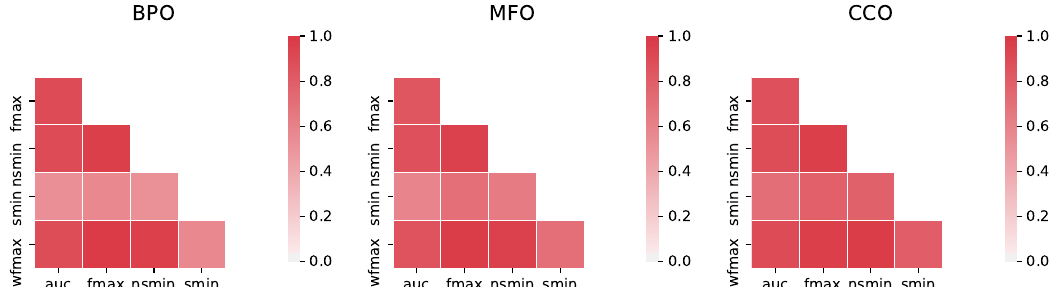
Figure 6. Pairwise absolute rank correlations between five different protein-centric evaluation metrics: area under the precision-recall curve (auc), maximum F1 score (fmax), maximum F1 score weighted by information content (wfmax), minimum semantic distance (smin), and minimum normalized semantic distance (nsmin). Correlation was calculated from the 146 methods that participated in CAFA3 [12] for the biological process ( left ), molecular function ( middle ) and cellular component ( right ) ontologies. More intense red color denotes larger absolute correlation. All pairwise correlations are statistically significant with uncorrected p -values < 10 − 11